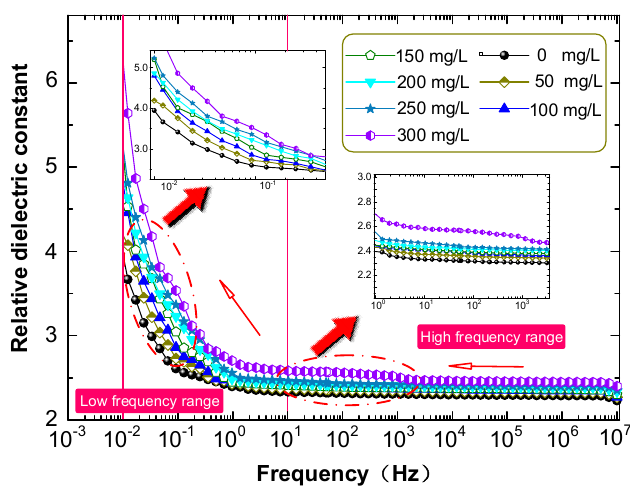
Figure 8. Broadband dielectric spectrum of CMIO and FO.